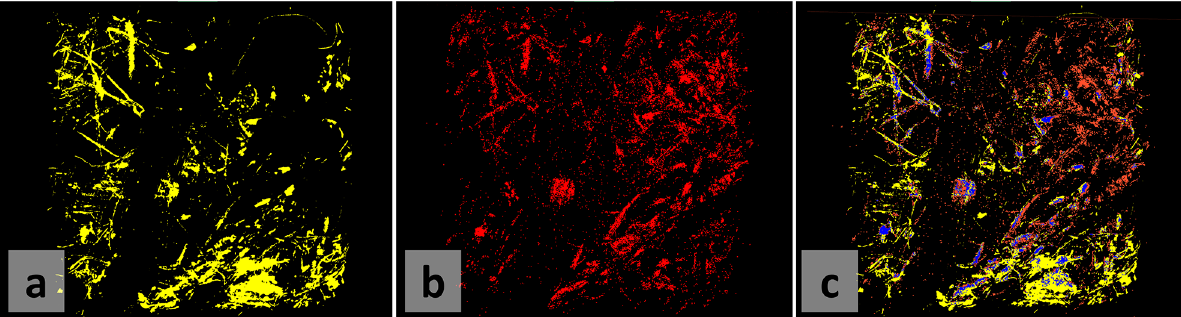
Figure 3. SEM-EDX validation of DECT on the surface of the sample, despite imaging differences making the overlay imperfect. ( a ) segmented high attenuation voxels in the DECT image, ( b ) segmented bromide mapping from SEM-EDX, ( c ) overlay of the SEM-EDX elemental mapping and the DECT image after automated registration. The blue phase indicates exact overlay of the two images: about 1/3 of the SEM-EDX segmented pixels.